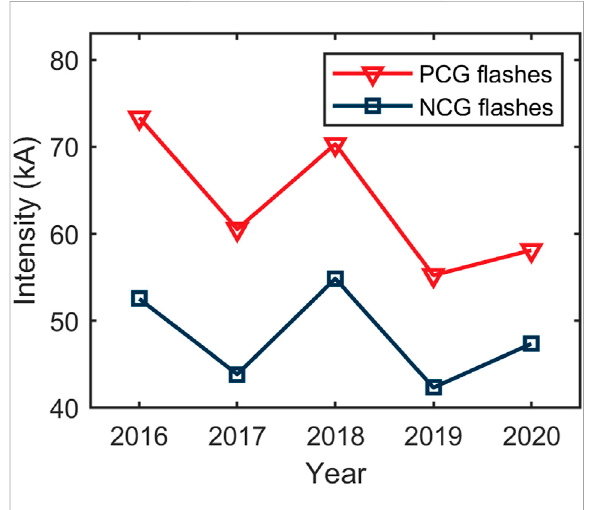
FIGURE 6 The line chart of the average current intensity of positive and negative CG lightning fl ashes from 2016 to 2020.